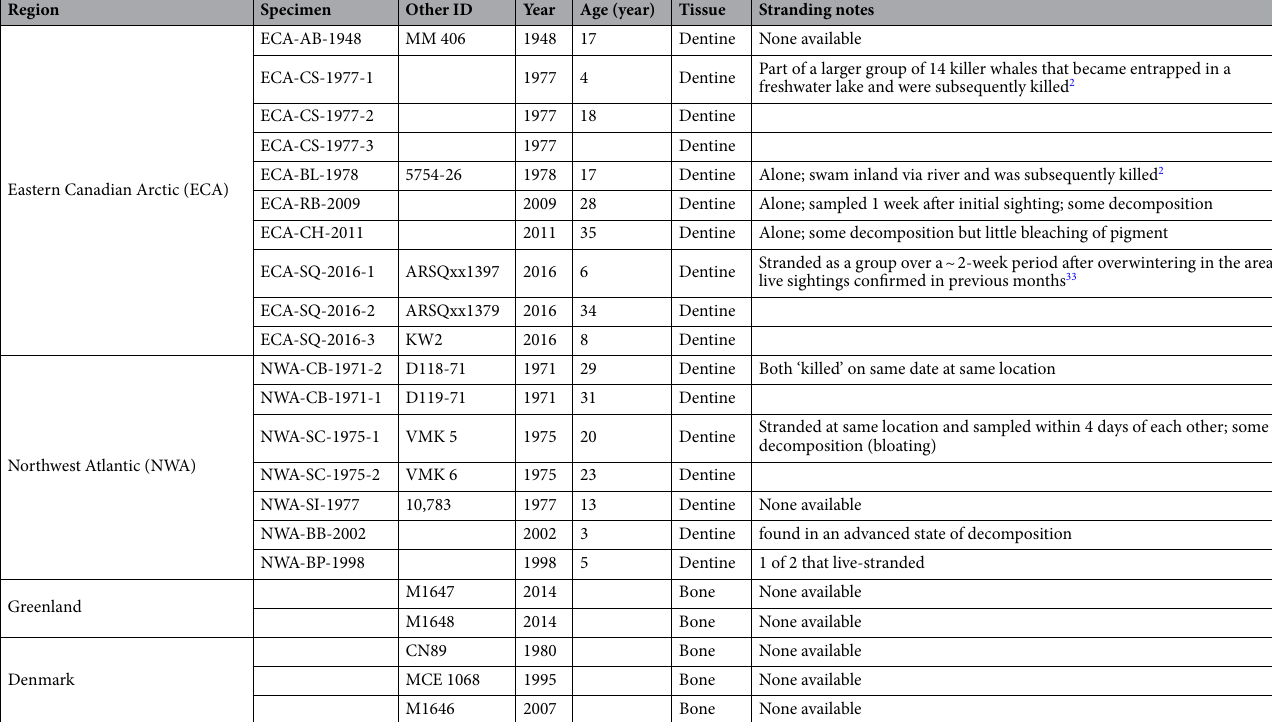
Table 1. Information on tooth and bone specimens collected from killer whales that stranded in the eastern Canadian Arctic (ECA) and Northwest Atlantic (NWA), as well as Greenland and Denmark. Four groups of whales stranded together in pairs or groups of three (ECA-CS-1977-X, ECA-SQ-2016-X, NWA-CB-1971-X, and NWA-SC-1975-X), while all others were alone. Most whales were stranded alive or in minimal state of decomposition. Stranding locations are shown in Fig.